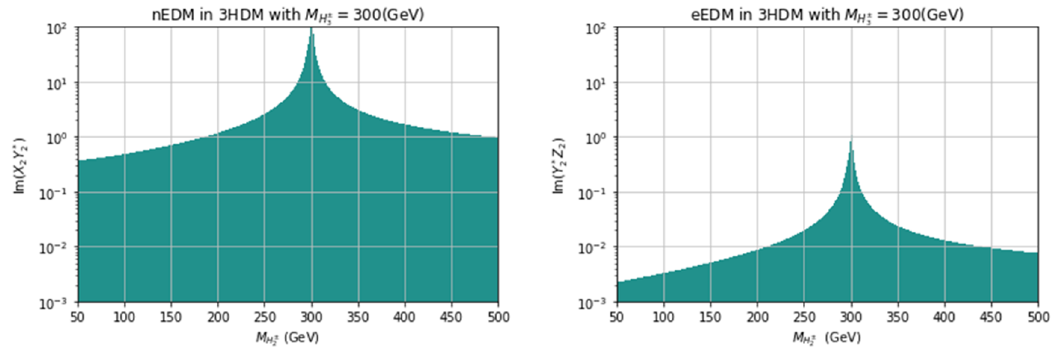
Figure 11 . Same as in figure 10 but for M